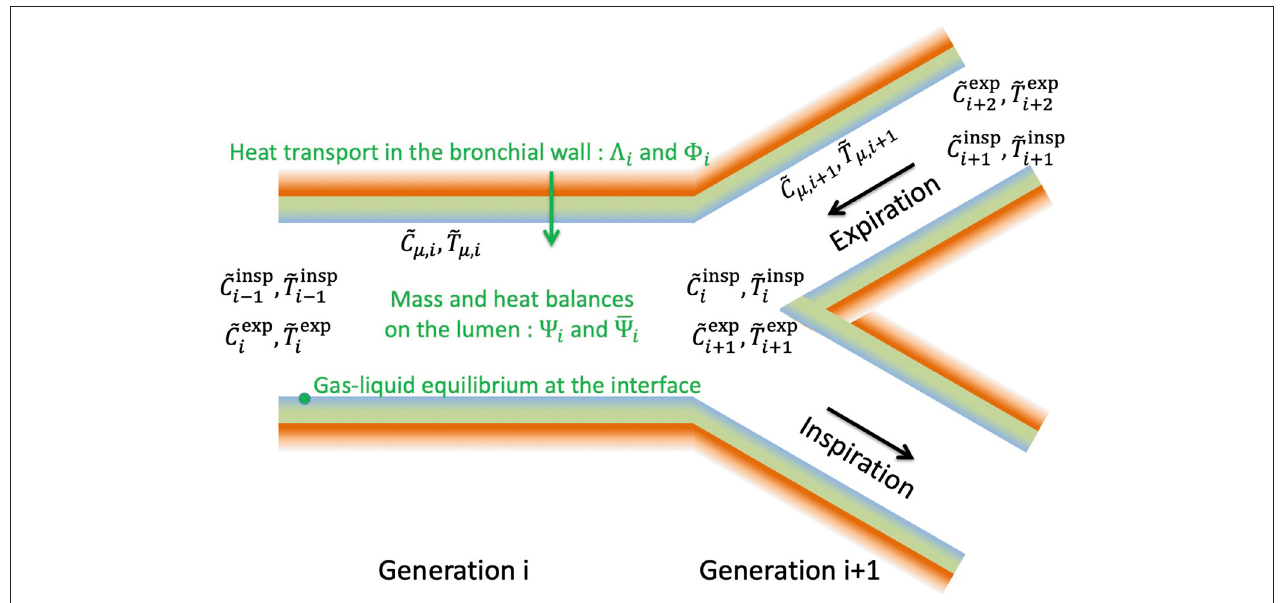
expiration as the air originating from the alveolar region is at body temperature and saturated with water. η i almost no condensation during expiration while η i that the water extracted from the mucosa during inspiration is almost totally given back during